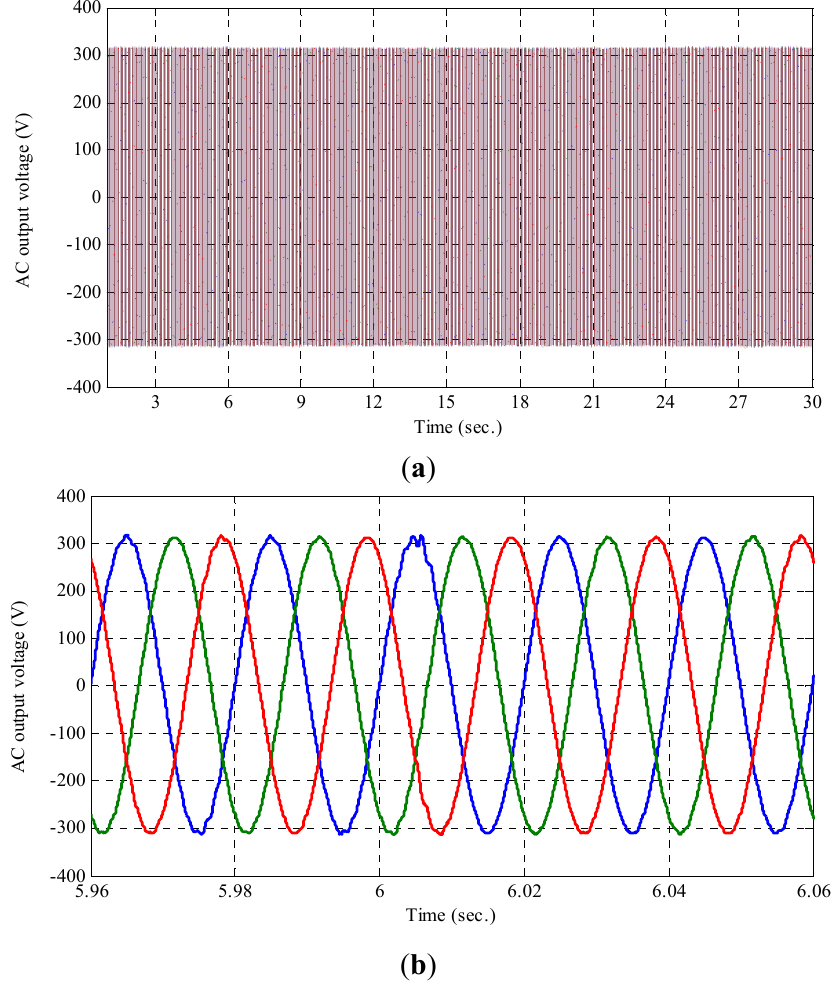
Figure 18. Output load voltages response with change in required load power. ( a ) AC output load voltages throughout the time simulation; ( b ) Load voltages at the instant of step up load power at time = 6.005 second; ( c ) Load voltages at the instant of step down load power at time = 18.005